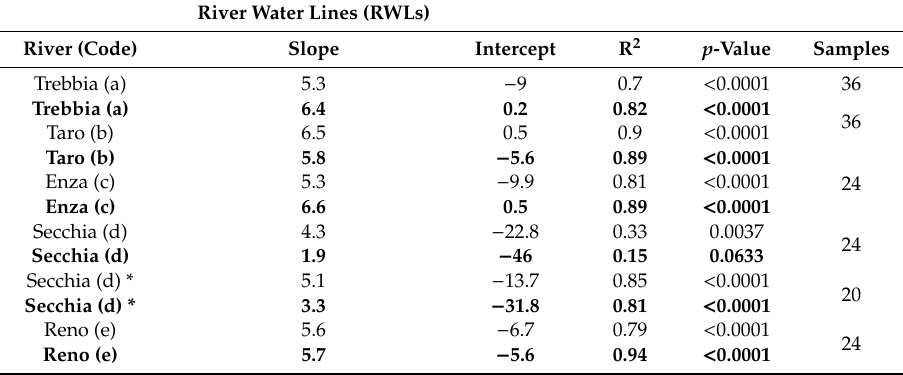
Table 3. Unweighted (RWLs) and Weighted River Water lines (WRWLs) for rivers considered in this study obtained from unweighted and weighted isotopic composition (in bold), respectively. The number of samples used for interpolations (ordinary least squares regression—OLSR) are also reported along with statistical parameters (R 2 and p -value). * Indicate the RWL and WRWL for Secchia river in case the 4 anomalous samples from January 2017 to April 2017 are not taken into